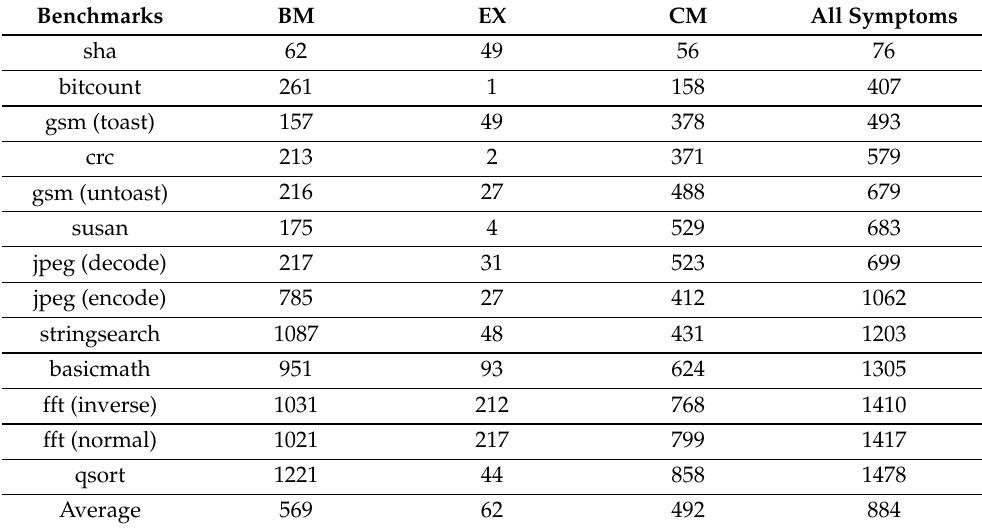
Table 2. Number of recoverable SOC-inducing faults (out of 3000) by the ReStore scheme based on the various